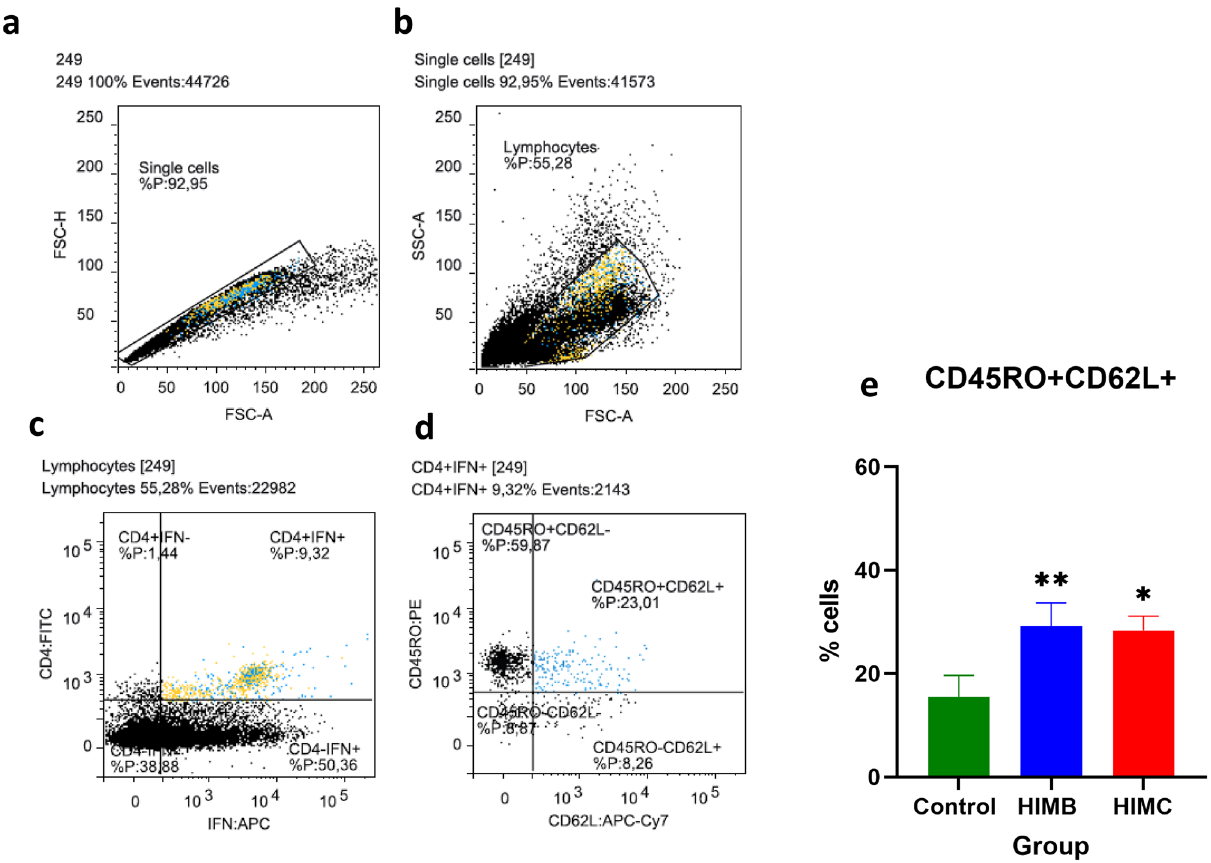
Figure 2. Flow cytometry analysis of IFN-γ producing lymphocytes before M. caprae challenge. The analysis was conducted with peripheral blood mononuclear cells (PBMC) isolated from all goats at week 0 (7 weeks post-vaccination and before M. caprae challenge) after stimulation with PPD-B overnight. ( a – d ) Representative plots of gating strategies. ( a ) Singlet cells identified by forward scatter (FSC). ( b ) Lymphocytes determined by side scatter (SSC). ( c ) Representative frequencies of CD4 cells and intracellular IFN-γ staining (IFNG + ). ( d ) Representative frequencies of the CD45RO/CD62L subsets gated from CD4 + IFN-γ + cells. ( e ) Frequencies (%) ± 95% CI of CD45RO + CD62L + within the CD4 + IFN-γ-producing cells. Blue dots are the CD4 + IFNG + CF45RO + CD62L + cells and the yellow dots represent the rest of CD4 + IFNG + cells. Groups: Control (N = 5, green), HIMB (N = 7, blue), HIMC (N = 5, red). * P < 0.05, **P < 0.01, Kruskal Wallis test with post hoc Dunn’s